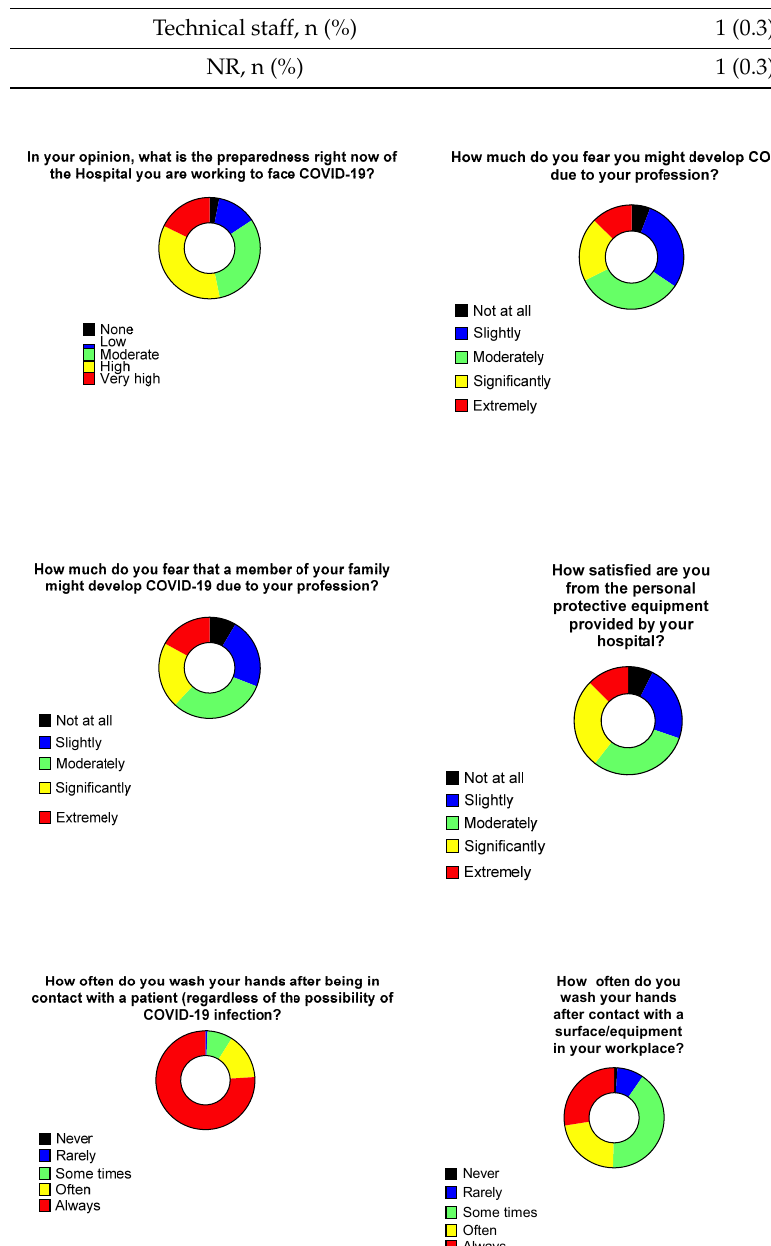
Figure 2. Personal perceptions regarding COVID-19 and hand-wash practices of healthcare